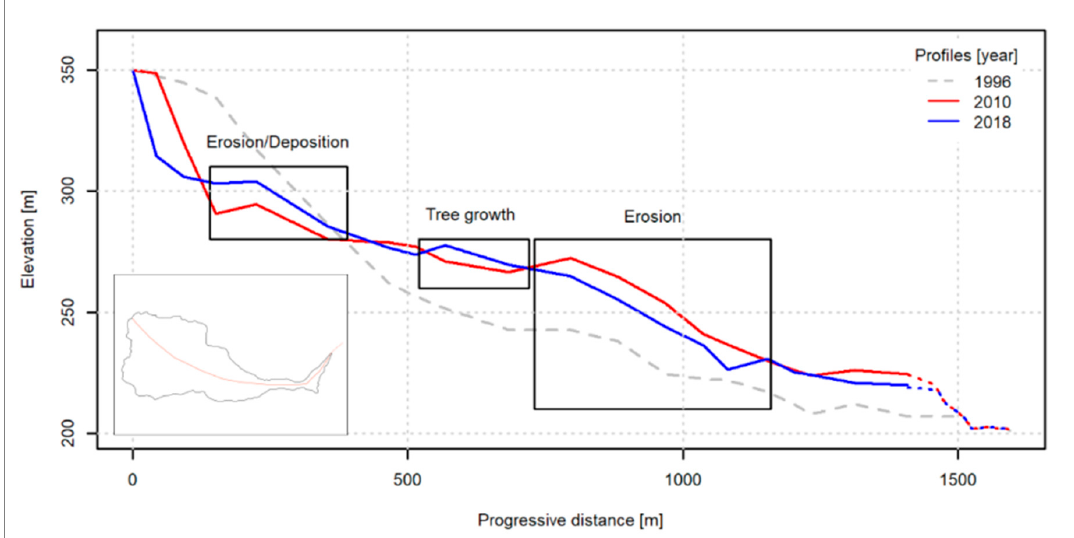
Figure 11. Cross section comparison depicting landslide evolution, the dotted lines represents the hypothetical profile outside the landslide border connecting with the undisturbed one.